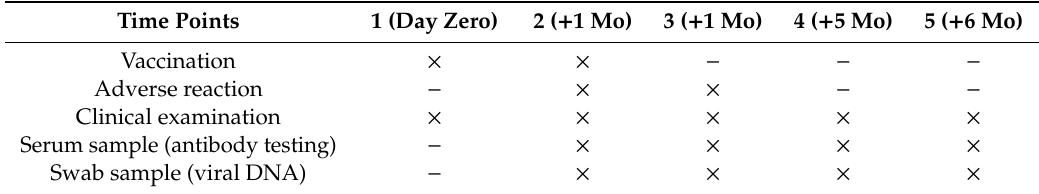
Table 1. Field trial vaccination against cowpox in two alpaca herds Germany: MVA vaccination regimen and sampling information. Time Points 1 (Day Zero) 2 ( + 1 Mo) 3 ( + 1 Mo) 4 ( + 5 Mo) 5 ( + 6 Mo) Vaccination × × − − − Adverse reaction − × × − − Clinical examination × × × × × Serum sample (antibody testing) − × × × × Swab sample (viral